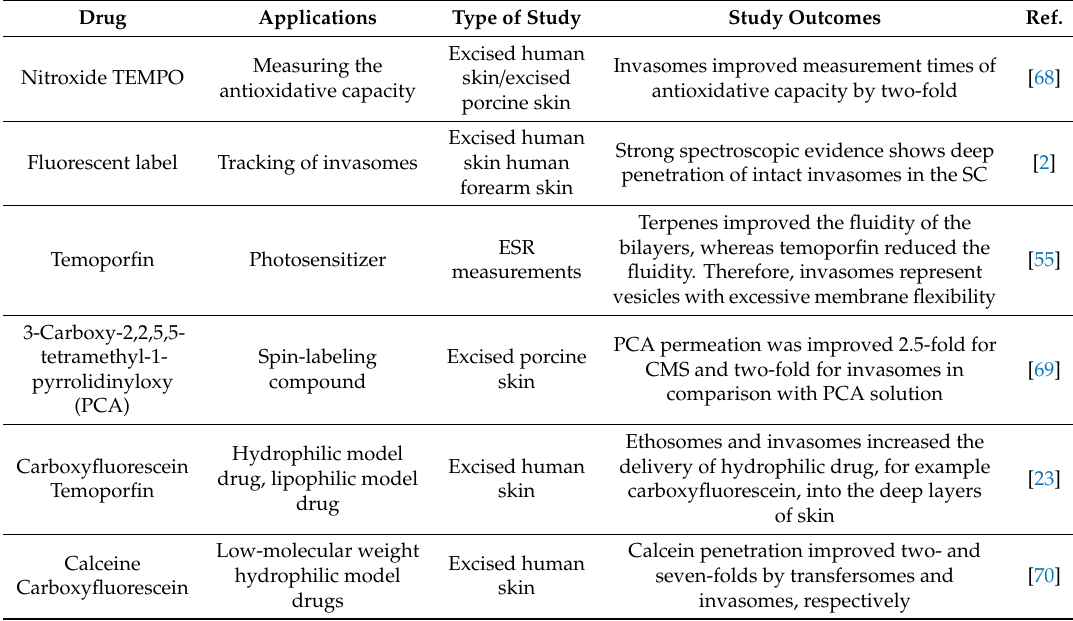
Table 2. Enhanced skin permeability of